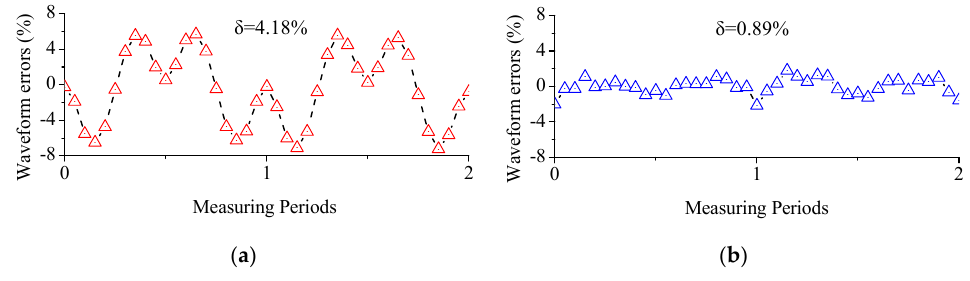
Figure 7. Error distribution of the demodulated sensor signal: ( a ) normalized outputs; ( b ) fundamental wave component of an EMD-based extraction approach.